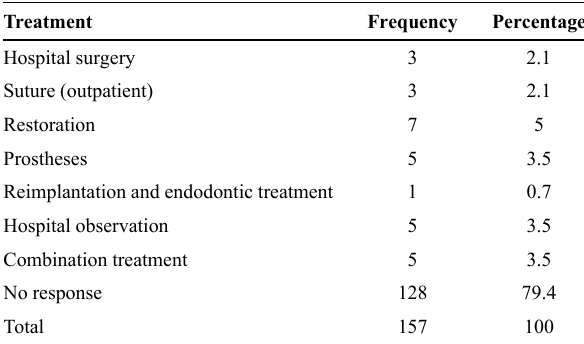
Table 5 - Distribution of responses per type of treatment for injuries caused during the practice of contact sports.